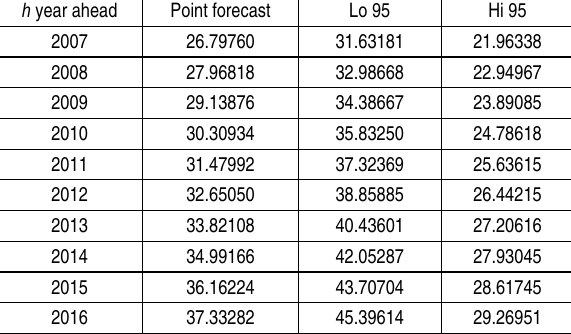
Table 3. Confidence intervals for forecasted k ASLC, Italian total